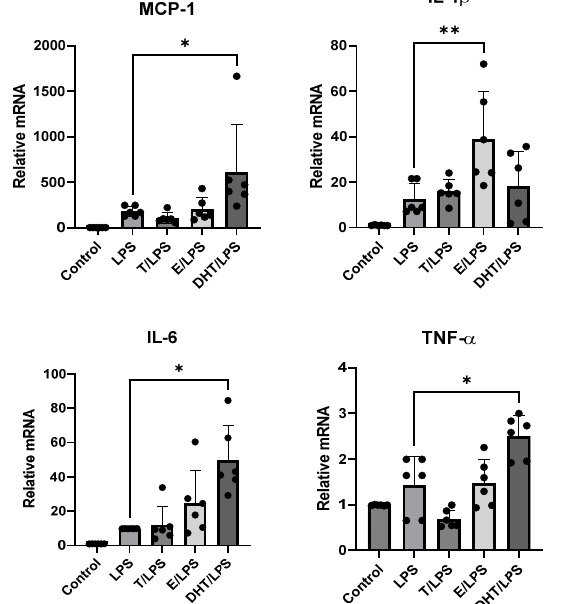
Figure 3. LPS-stimulated expression of inflammatory cytokine genes(MCP-1, IL-1 β , IL-6, TNF- α in human adipocytes in the absence and presence of testosterone (T), 17 β -estradiol (E), and dihydrotestosterone (DHT). Control cultures were incubated in the presence of vehicle only. A complete set of six experiments for each treatment was performed from each subject and run in triplicate. Data are expressed as mean ± DS. Each black dot represents the mean of triplicate measurements of a single experiment. * p < 0.001; ** p < 0.05.